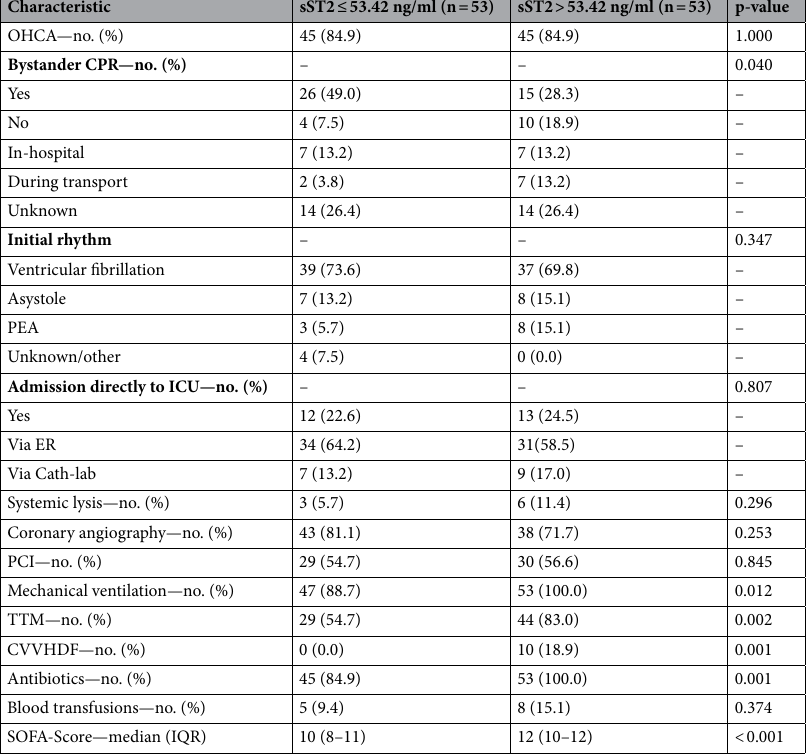
Table 2. Patient characteristics regarding CPR and post-resuscitation care. CPR cardiopulmonary resuscitation, CVVHDF continuous veno-venous hemodiafiltration, ER emergency room, ICU intensive care unit, IQR interquartile range, OHCA out of hospital cardiac arrest, PCI percutaneous coronary intervention, PEA pulseless electrical activity, SOFA severity of organ failure assessment, TTM targeted temperature